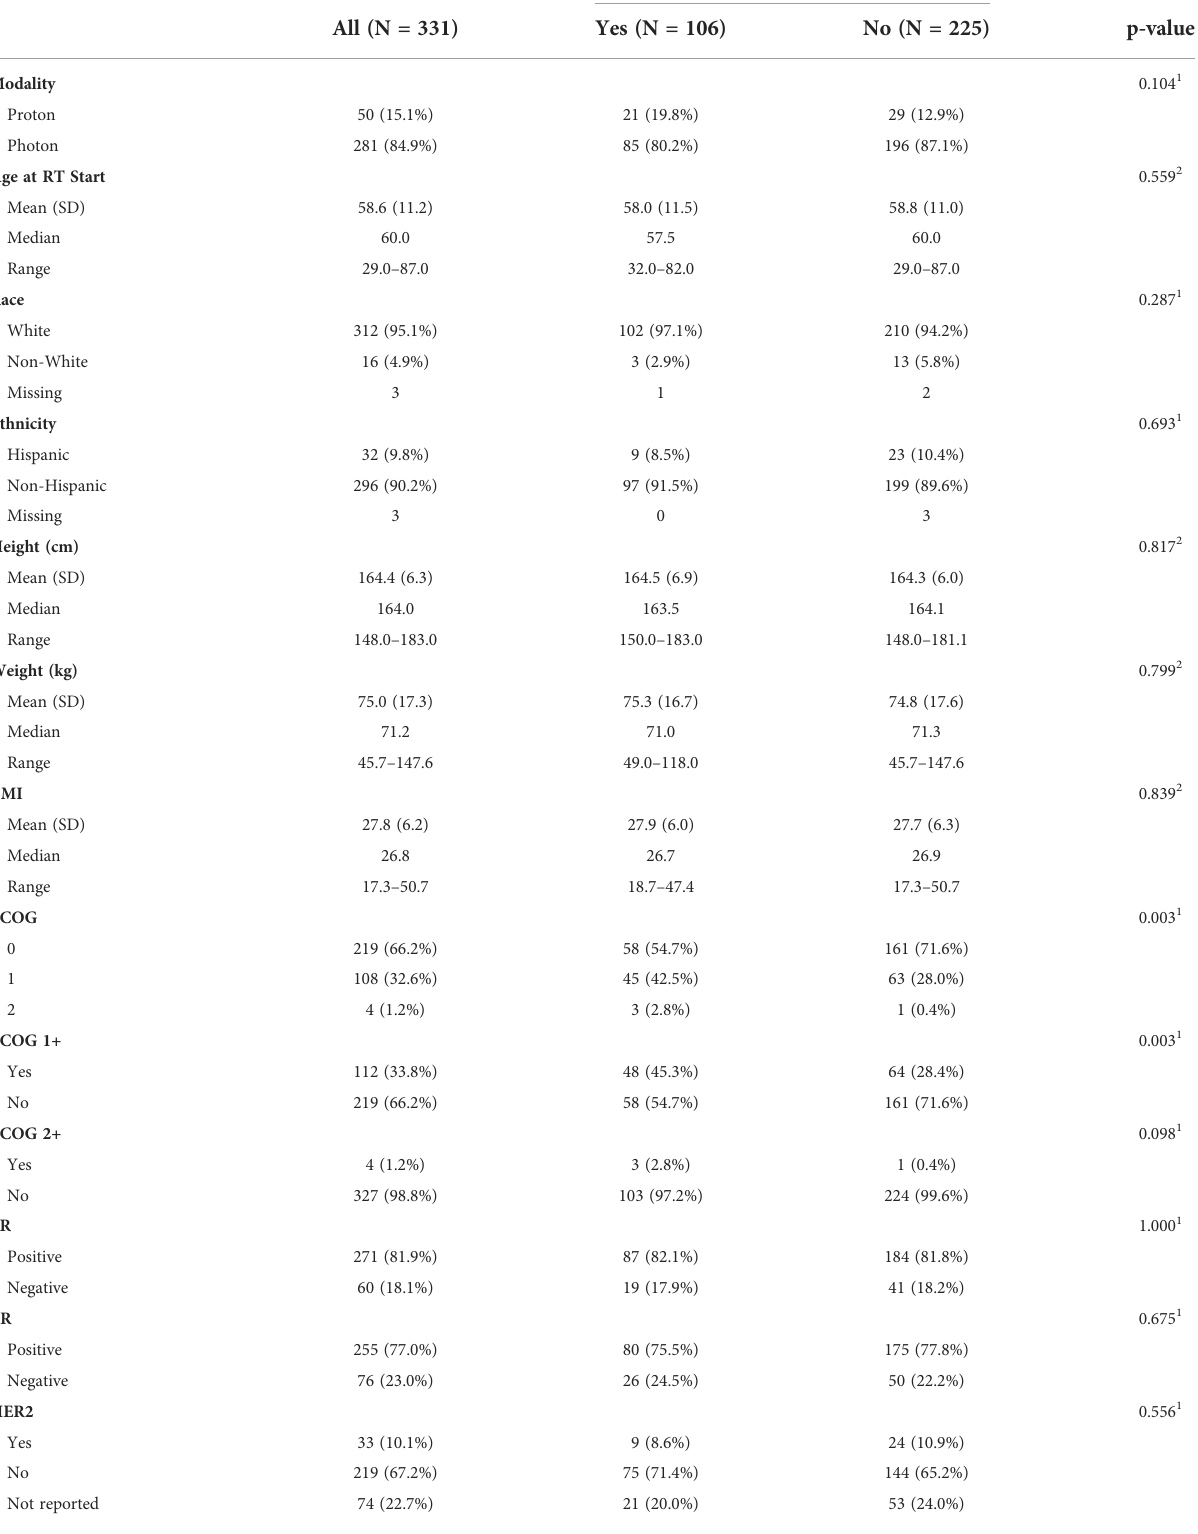
TABLE 3 Patient characteristics by patients with any grade 3+ PRO